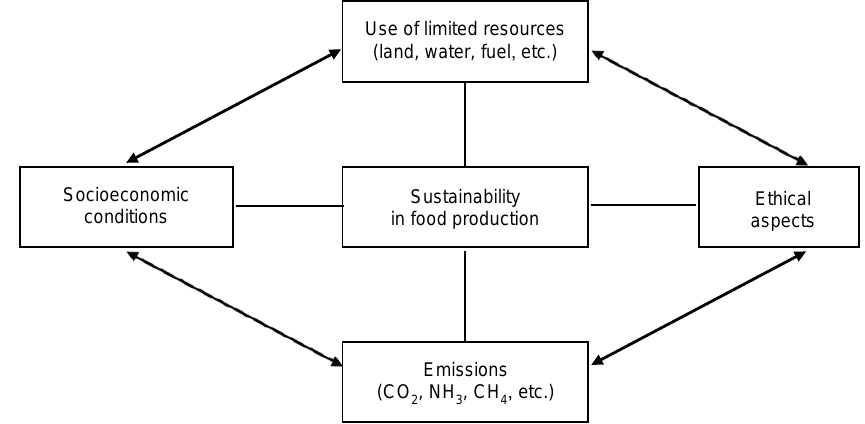
Figure 1. Sustainability as a balance between the use of limited natural resources, emissions, and socioeconomic and ethical conditions to produce food of animal origin (Flachowsky and Hachenberg,